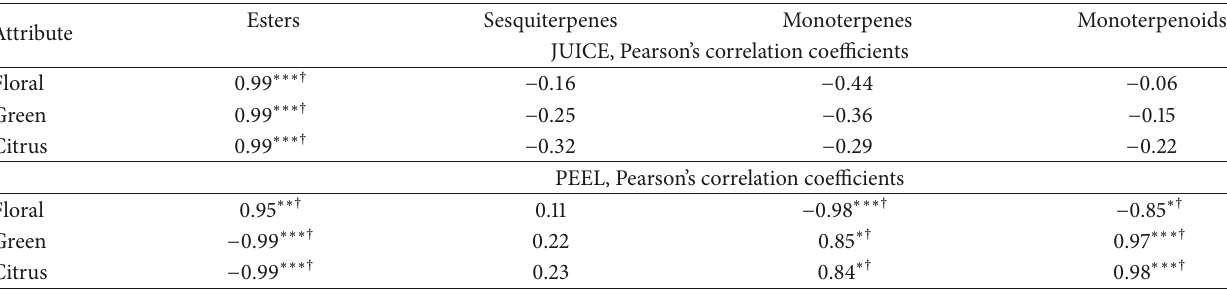
Table 7: Pearson’s correlation coefficients among sensory descriptive attributes (floral, green, and citrus) and total content of the main volatile families (esters, sesquiterpenes, monoterpenes, and monoterpenoids) of the juice and peel of endangered Spanish lime and lemon